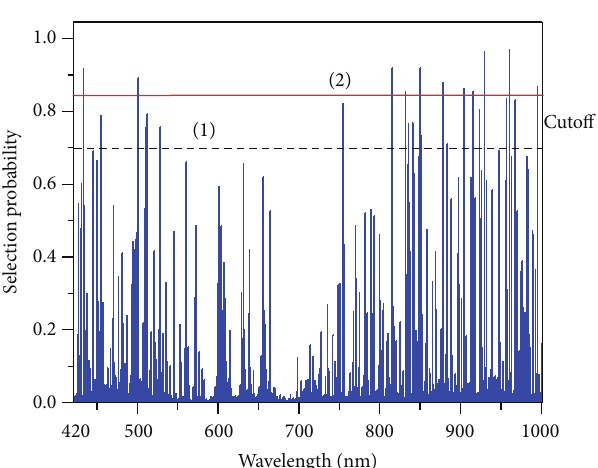
c Numbers of the wavelengths used for analysis. d